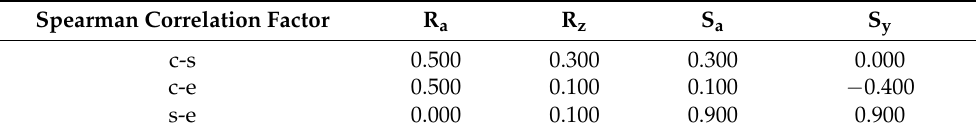
Table 3. Correlation factor values related to conditioning method, after conditioning.